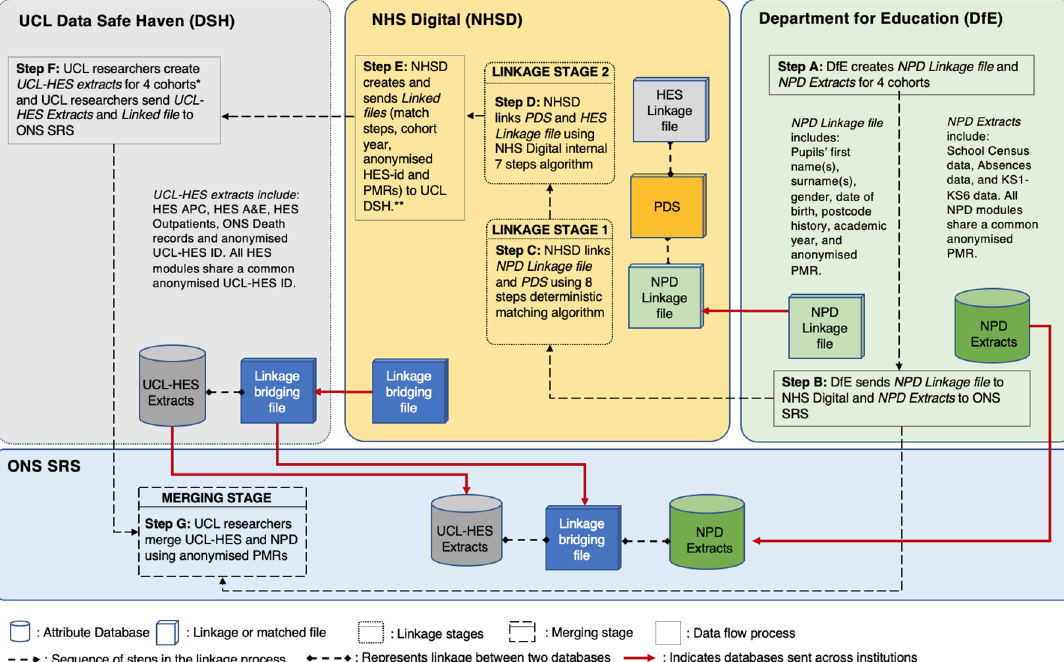
Figure 1: Data flow and linkage process for linkage between the national pupil database, the personal demographic service and hospital episode statistics